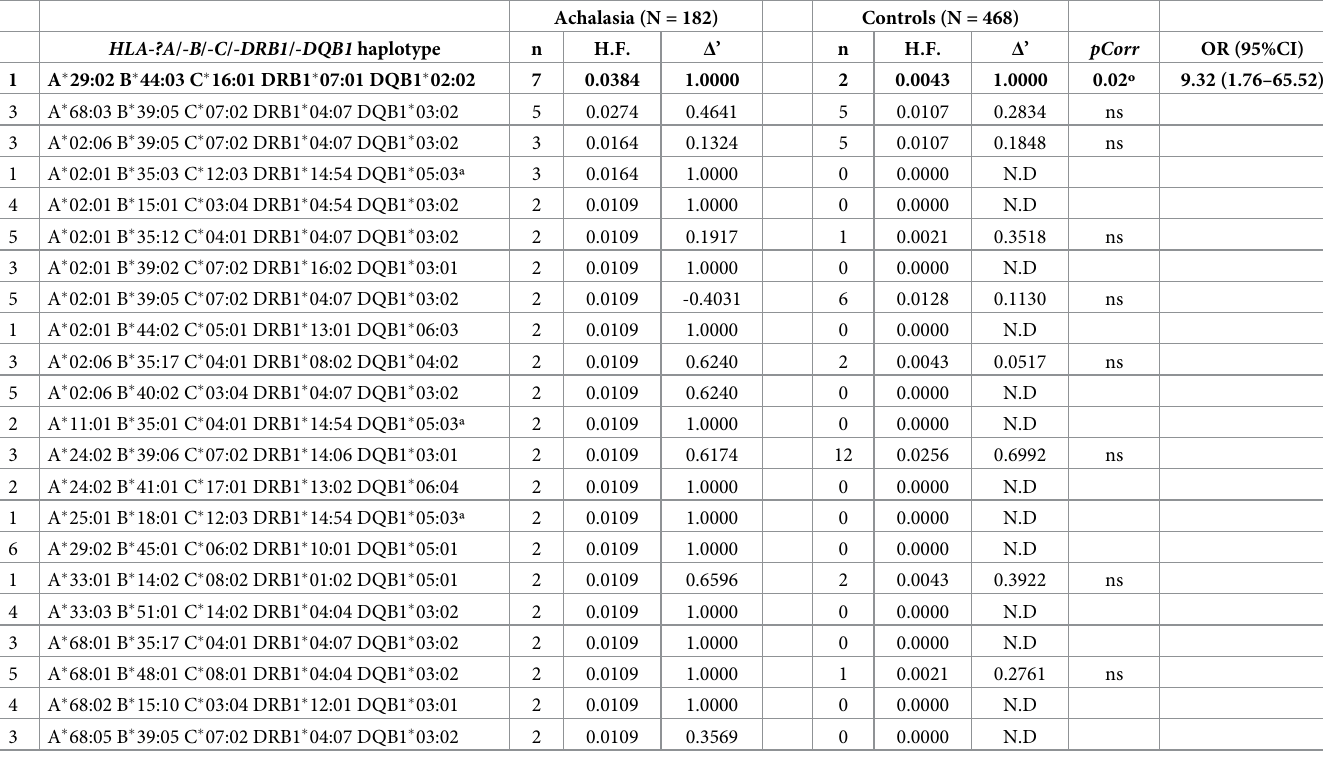
Table 7. Most frequent HLA-A/-B/-C/-DRB1/-DQB1 conserved extended haplotypes in Achalasia patients and healthy controls.